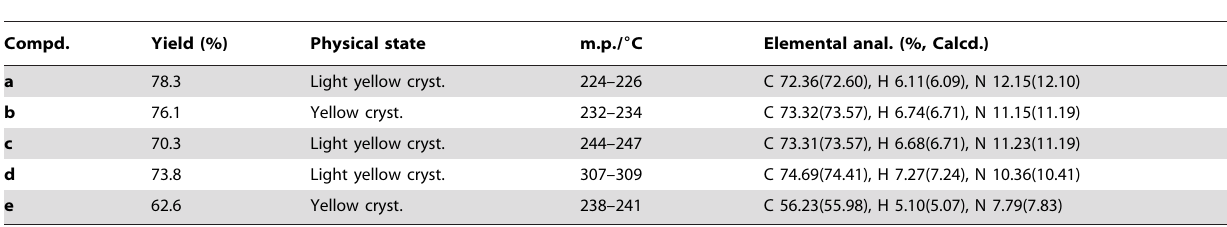
Table 9. Yield, melt point, and EA data of compounds a–e.